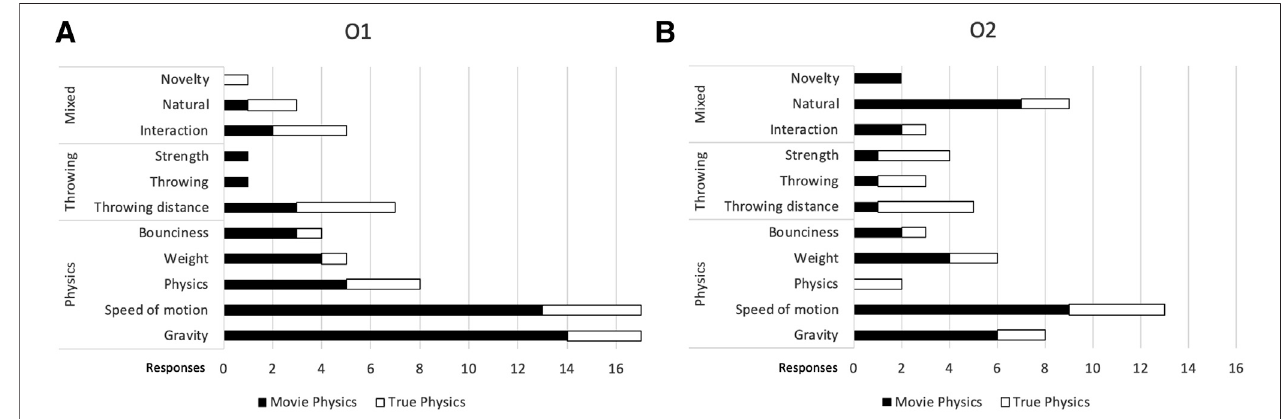
FIGURE 8 | Qualitative codes for responses O1 (A) and O2 (B) according to pereived realism in Study 2